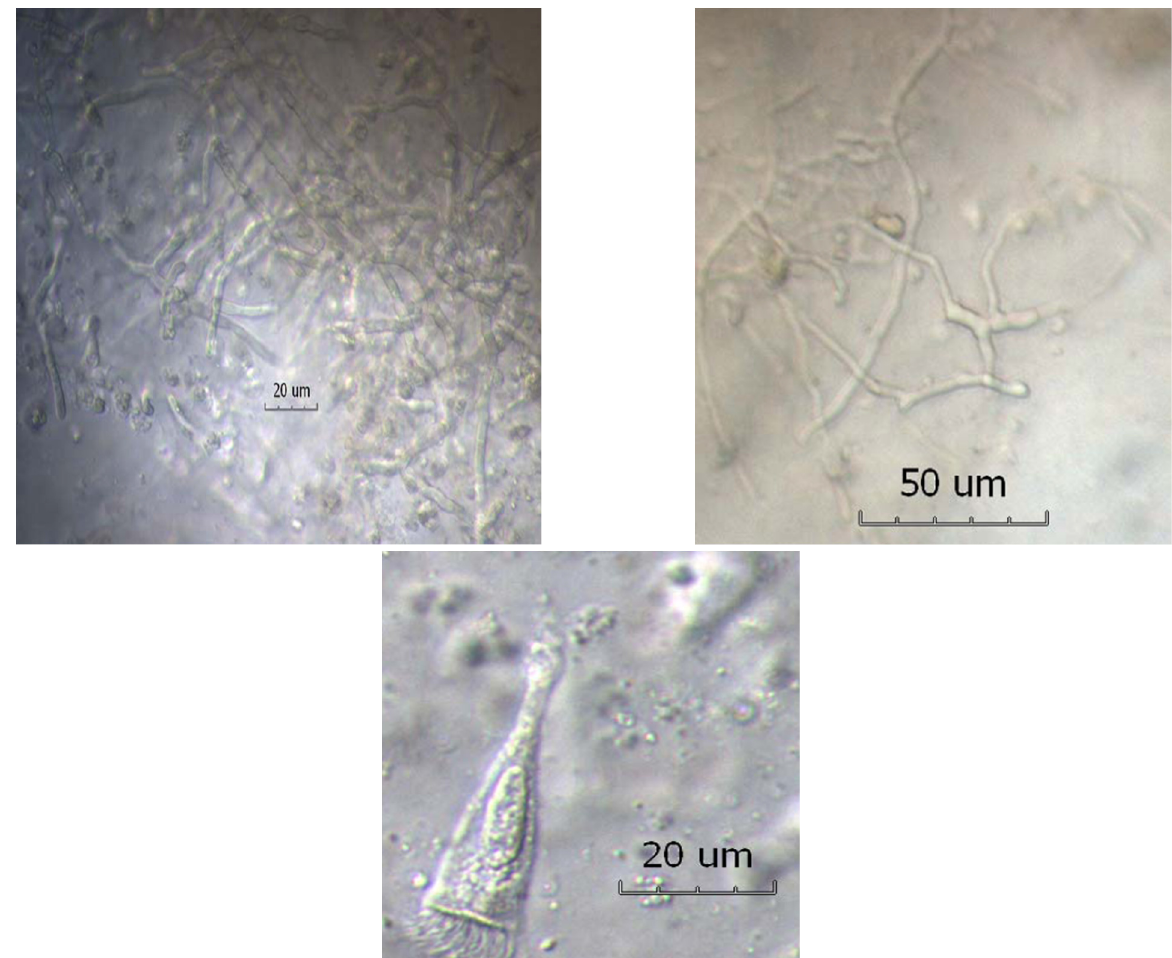
Figure 2. Persistent non-invasive endobronchial growth of thermotolerant fungi, particularly Aspergillus fumigatus ( Af ), occurs in mucus plugs seen in muco-obstructive diseases (here, in an expectorated sputum sample from a patient with cystic fibrosis and allergic bronchopulmonary aspergillosis). Upper panels show typical branching Af hyphae. The lower panel shows T2 inflammatory response with a desquamated ciliated epithelial cell surrounded by eosinophilic granulocytes, some of which appear to have degranulated. Adapted from reference [12]. Reproduced with permission of the © ERS